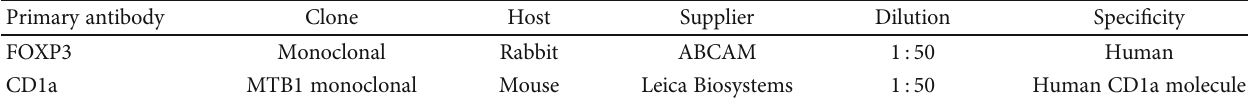
Table 1: Immunohistochemistry data.